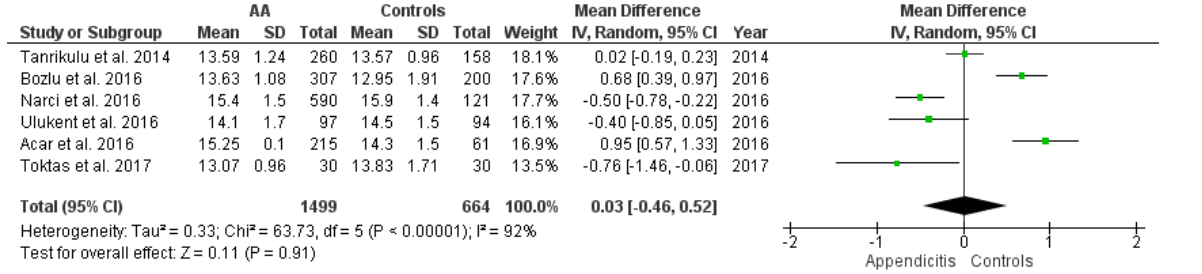
Figure 2. Forest plot comparison between the two patient groups (AA versus healthy controls) in terms of the average values of red cell distribution width. Abbreviations: AA—acute appendicitis; IV—inverse variance; and CI—confidence interval.